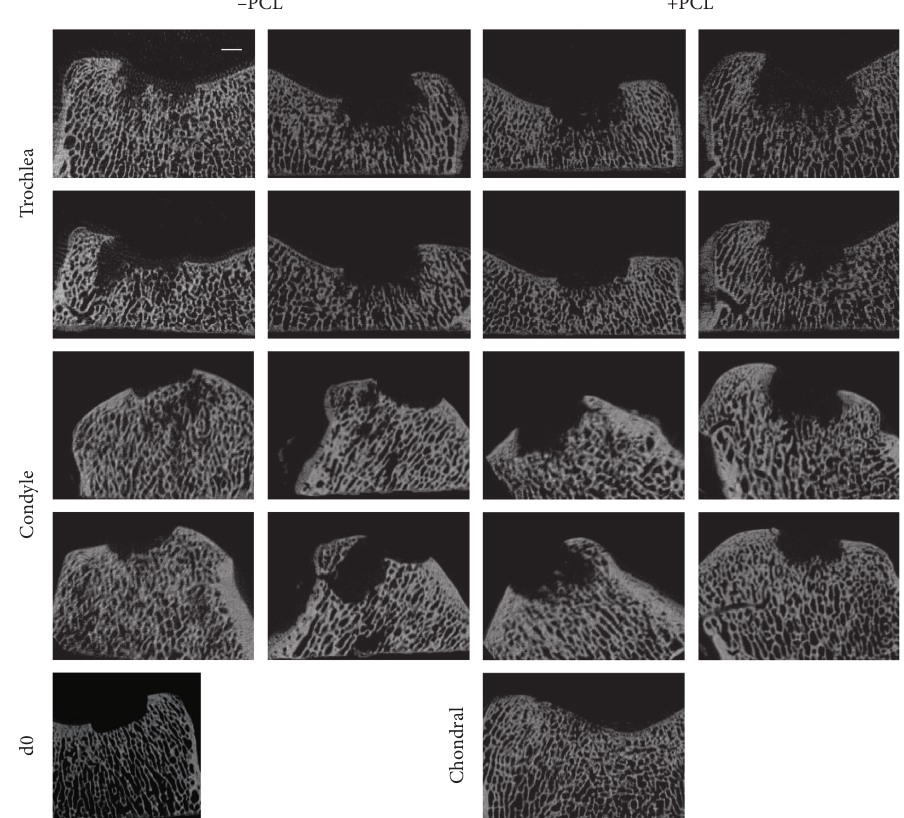
Figure 5: μ Ct visualization of bone lysis 4 weeks after implantation of nonreinforced and PCL-reinforced constructs in superficial osteochondral defects. Severe bone lysis was found in all defects regardless of the implanted construct. A reference d0 scan is shown, indicating the original defect depth, as well as a chondral defect showing no bone lysis. Scale bar: